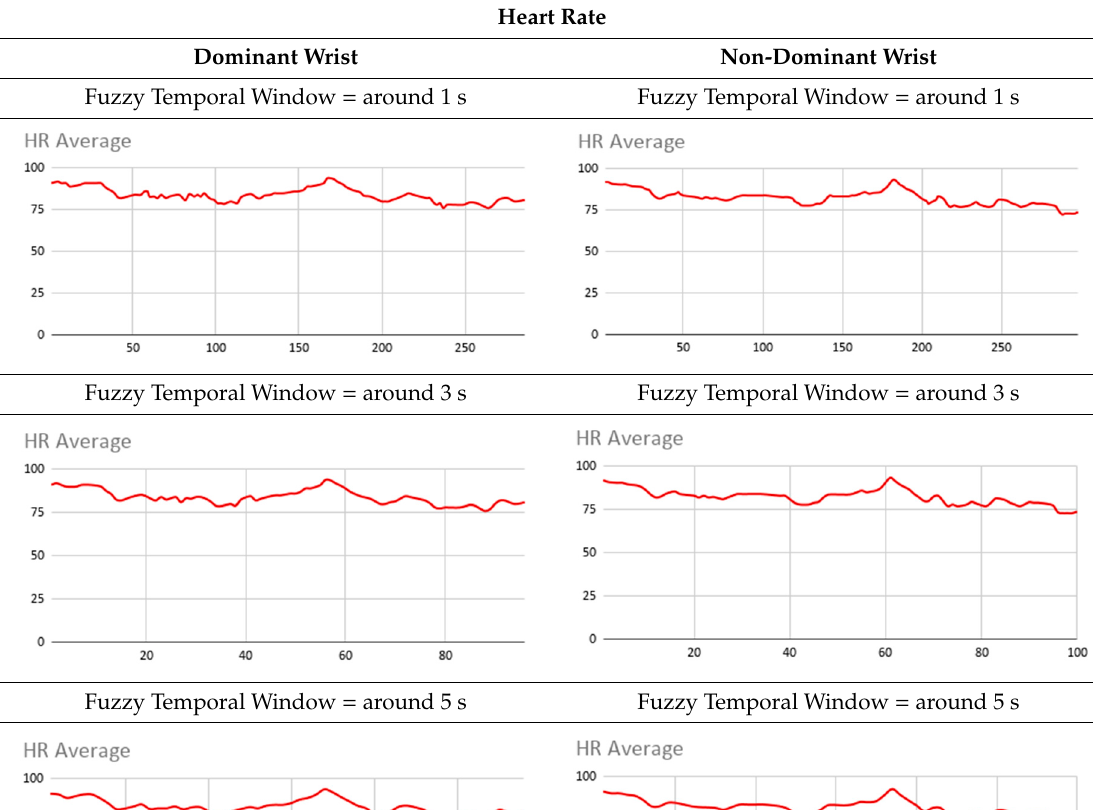
Table 6. Heart results with di ff erent fuzzy temporal windows from both wrists. Table 6. Heart results with different fuzzy temporal windows from both wrists. Table 6. Heart results with different fuzzy temporal windows from both wrists. Table 6. Heart results with different fuzzy temporal windows from both wrists. Table 6. Heart results with different fuzzy temporal windows from both